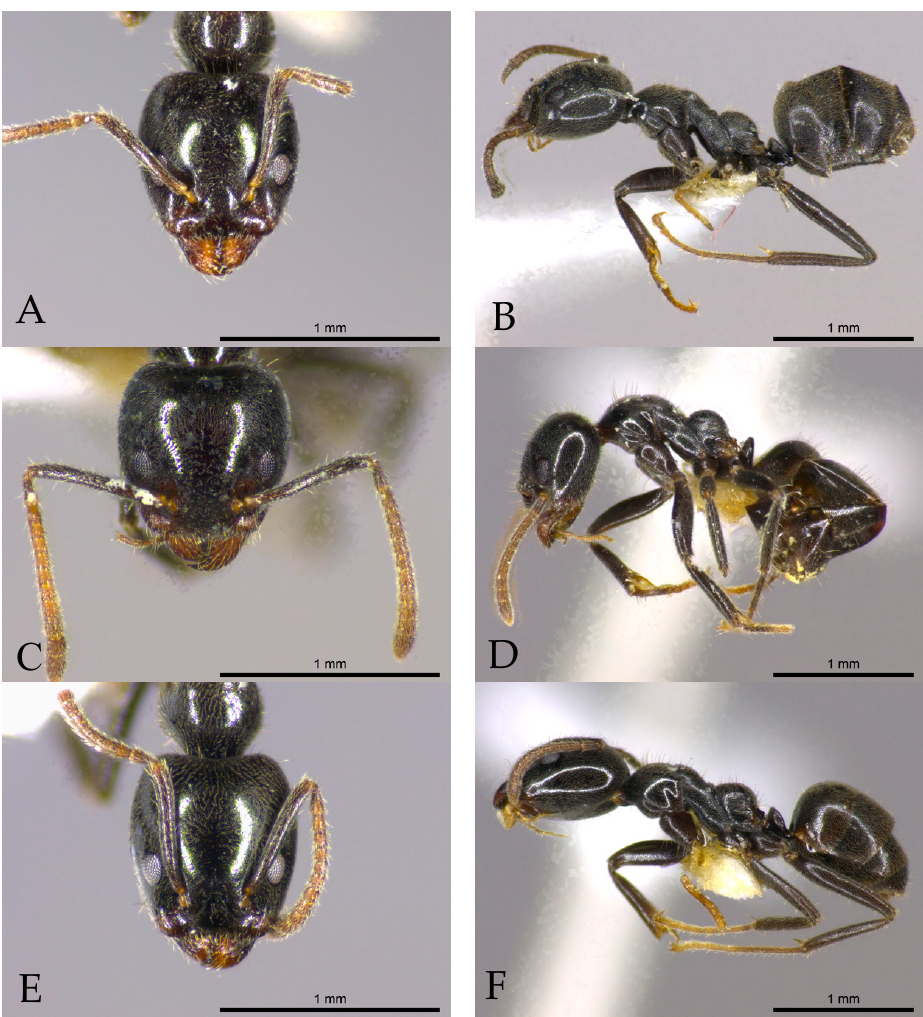
Figure 8. Head and lateral views of Anonychomyrma sp. N ( A , B ), sp. F ( C , D ) and sp. K ( E , F ).